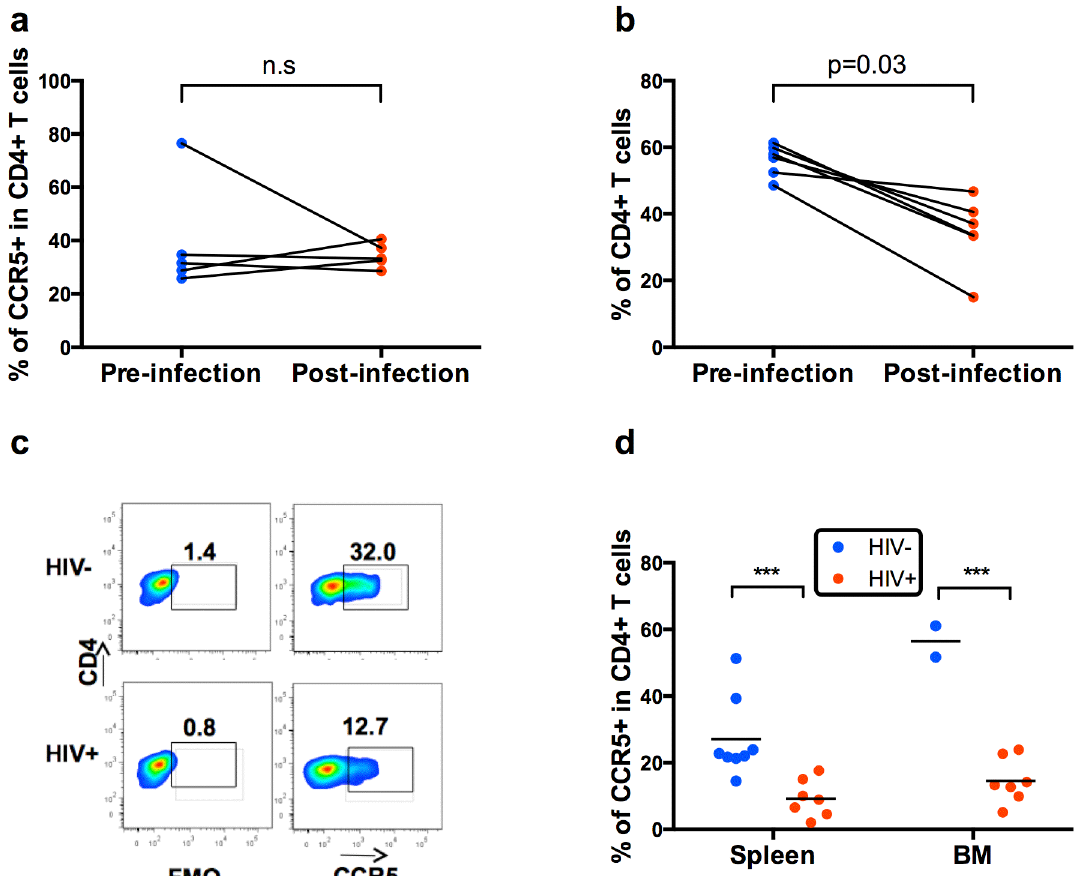
Fig 3. Specific deletion of CD4 + CCR5 + T cells in the periphery but not in the blood. Frequencies of CCR5 + in CD45 + CD3 + CD4 + T cells (a) and of CD4 + in CD45 + CD3 + T cells (b) measured in the blood before and 23 days after infection of HIV-infected NSG HuMice (ns = not significant from a Wilcoxon matched-pairs signed rank test) (c) A representative FACS profile showing depletion of CCR5 + cells in the spleen of an infected animal is pictured. Numbers indicate the frequency of positive-cells in the depicted gate. FMO = Fluorescence minus one (d) Frequencies of CCR5 + cells in human CD45 + CD3 + cells from the spleen and the bone marrow (BM) 37 days after HIV infection (HIV+). In this experiment, 25 weeks-old NSG HuMice were infected with 50 ng p24 of CCCR5-tropic HIV. Control mice (HIV - ) are non-infected NSG HuMice from two independent experiments euthanized at 13 and 17 weeks of age. Statistical significance was determined using the Holm-Sidak method, with alpha = 5.0%.